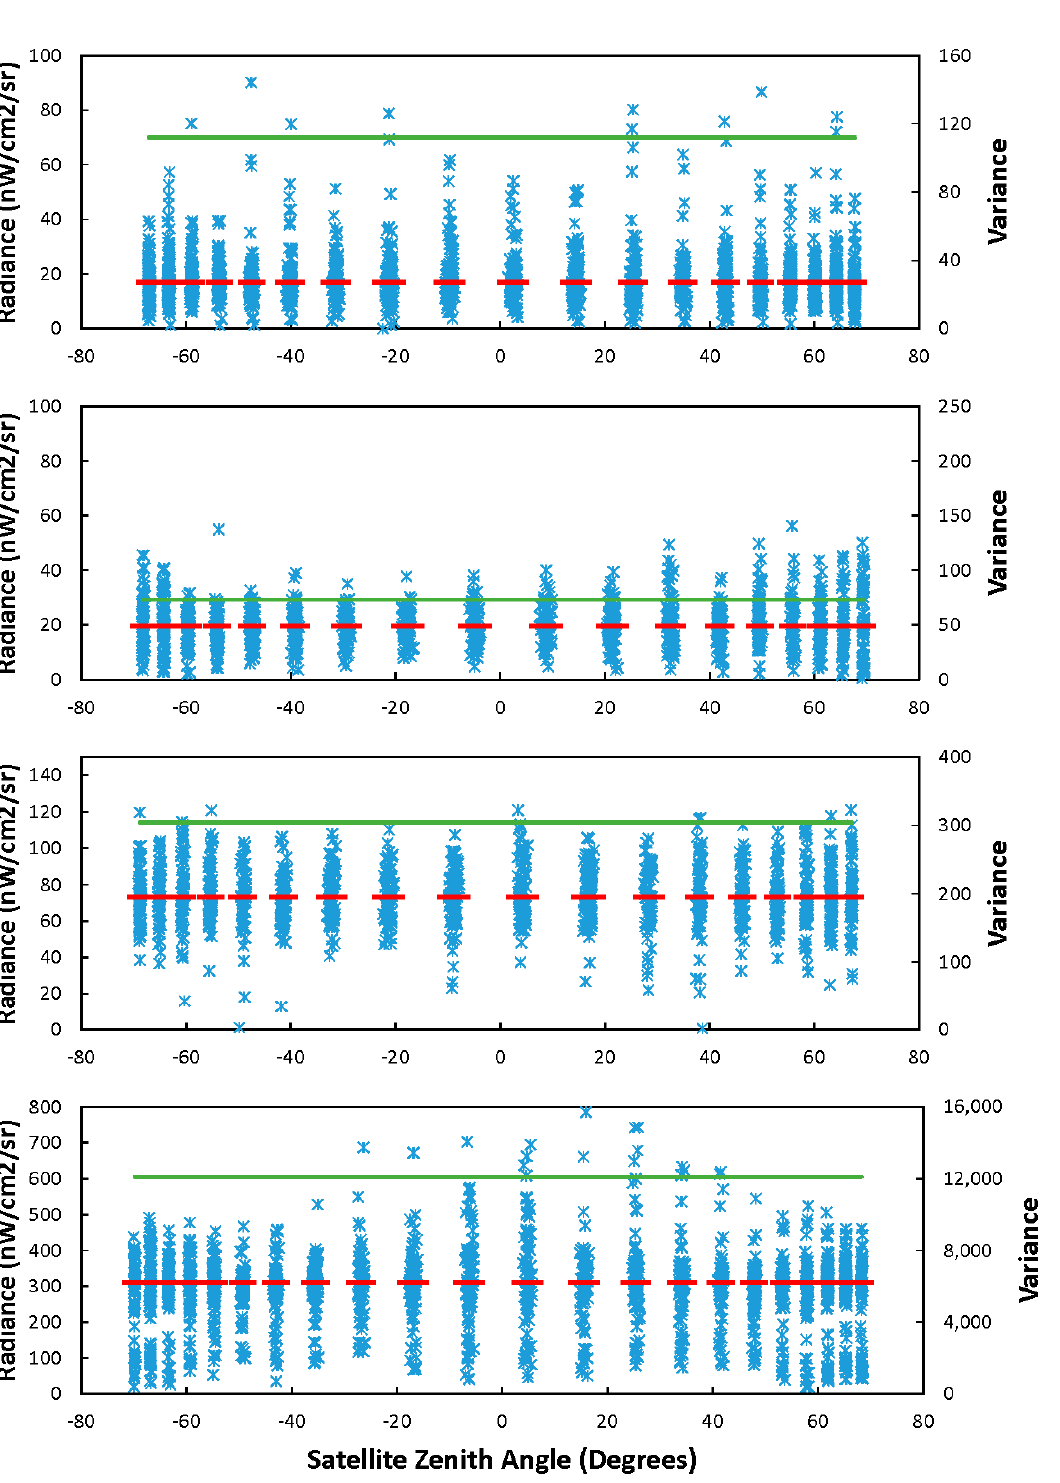
Figure 8. Nadir normalized DNB radiance versus the satellite zenith (satz) angle for the temporal profiles shown in Figure 7. The medians (red lines) are now aligned within the satz column. The IQRs (green horizontal lines) declined, except in the case of peak at nadir.